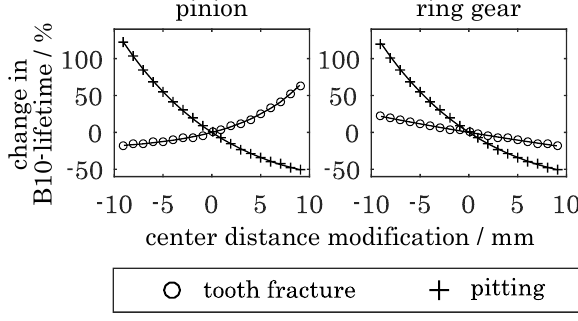
Figure 9: B 10-lifetime changes for center distance modification, Load: 150 t, Wind speed: Beaufort 5